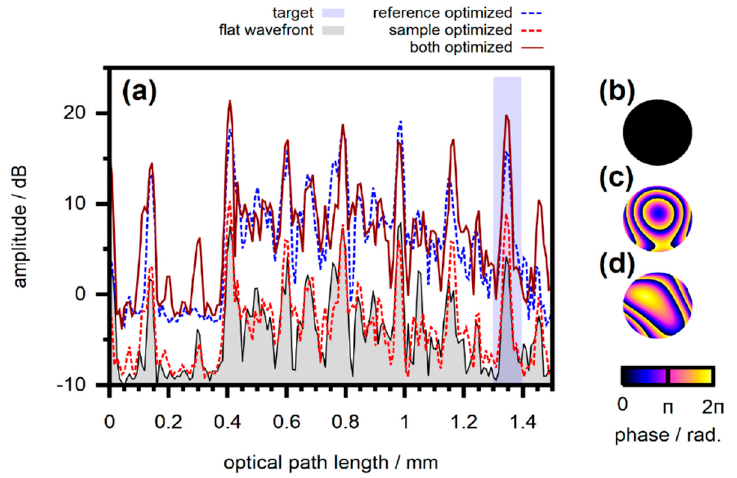
Figure 12. Adaptive optics correction and enhancement of OCT signal. ( a ) OCT A-scans taken at the sample with different phase patterns applied. The depth-range from which the feedback signal for wavefront optimization is calculated is highlighted (light blue area). ( b ) Flat wavefront applied to both beams for the acquisition of the initial scan (signal marked by grey area). The pattern applied corresponds to a beam diameter of 4 mm at the SLM. ( c , d ) Wavefronts optimized at the sample beam and reference beam, respectively. Image adapted from [8,101], with permission. The signal enhancement obtained is clearly visible.